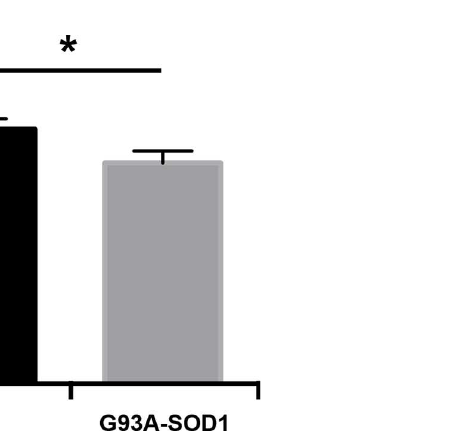
Fig 3. Conditioned media from SOD1-G93A astrocytes is toxic to motor neurons. Astrocyte-conditioned media was added to primary motor neuronsand their viabilitywas assessedafter 7 days using anti-NeuN antibody (Student’s t-test, p <